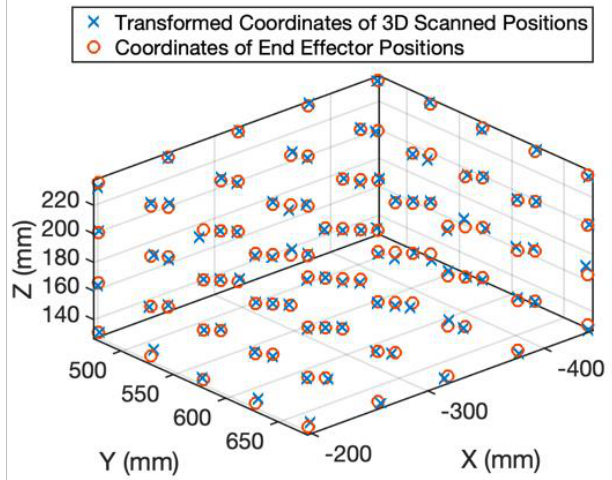
Figure 2. The coordinates of the end e ff ector positions and the transformed coordinates of the 3D scanned positions.